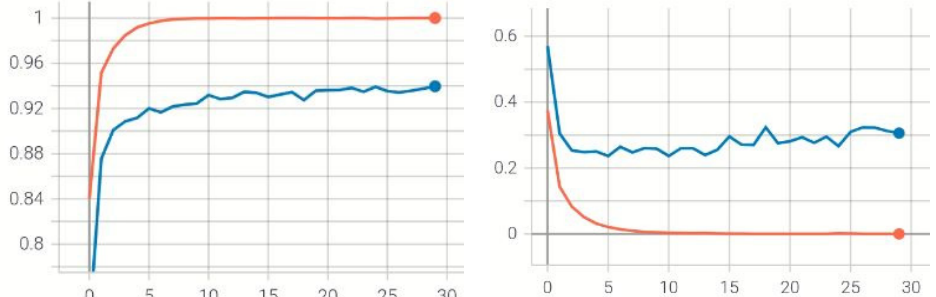
Figure 6. The training output of classifier network on the Celeb-DF v2 dataset. The accuracy of the model is on the left, while the loss of the model is on the right. The red represents the training outcomes, while the blue represents the validation outcomes.